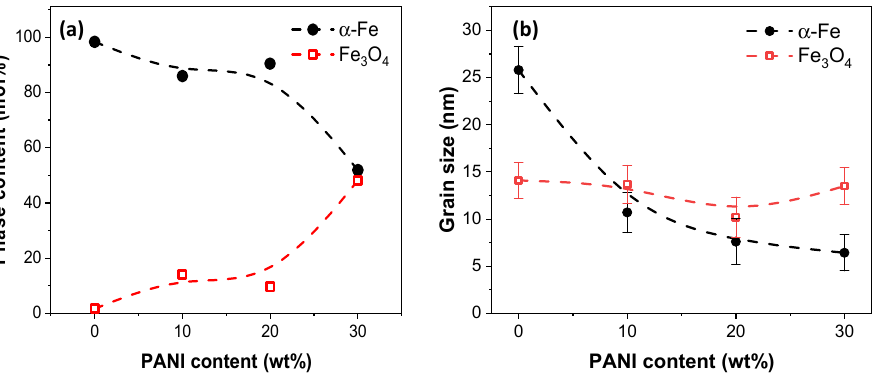
Figure 6. ( a ) Phase content and ( b ) grain size of α -Fe and Fe 3 O 4 analysis via XRD. The connecting spline dotted curves are only to guide the eyes for the observation of the trend.